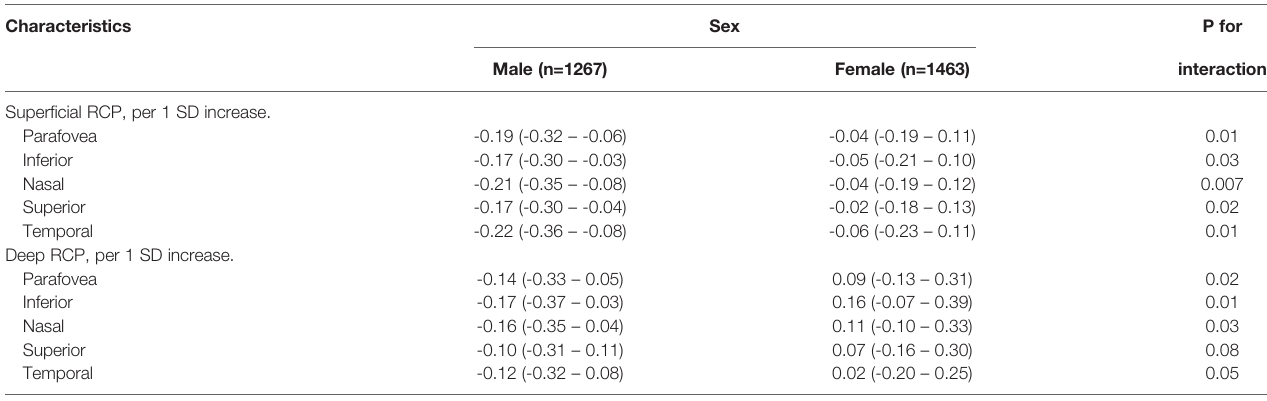
TABLE 7 | Association between continuous serum uric acid and retinal capillary plexus.